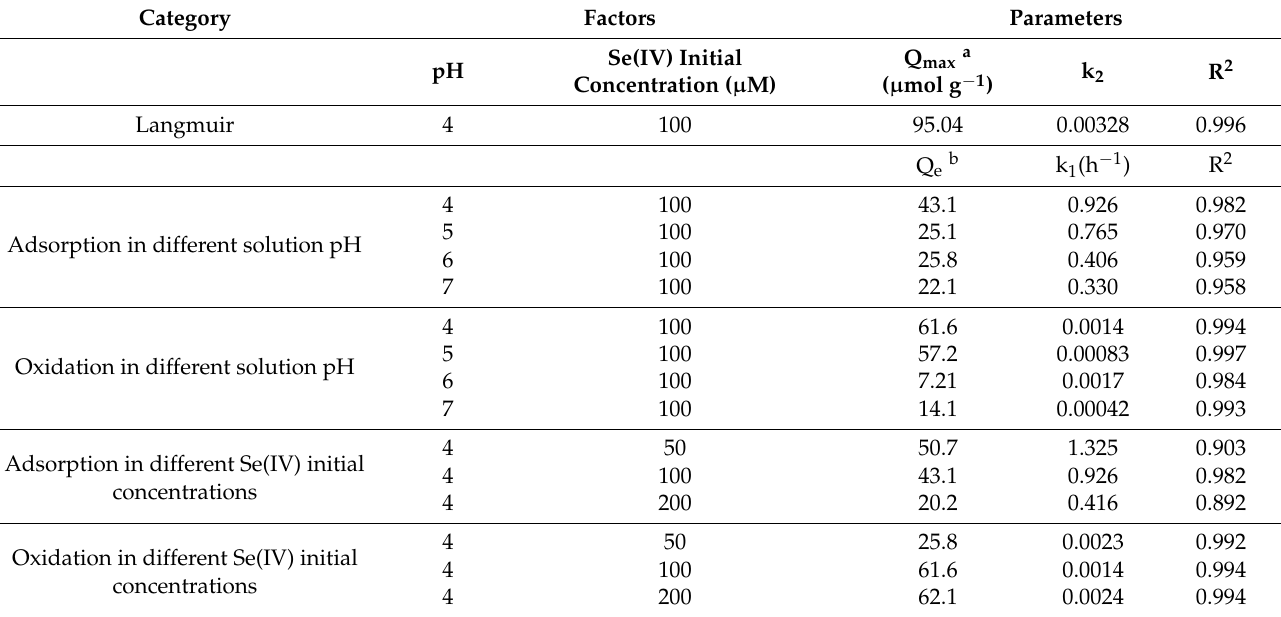
Table 1. The kinetic parameters of Se(IV) for isothermal adsorption and oxidation on δ -MnO 2 in batch experiments. Category Factors